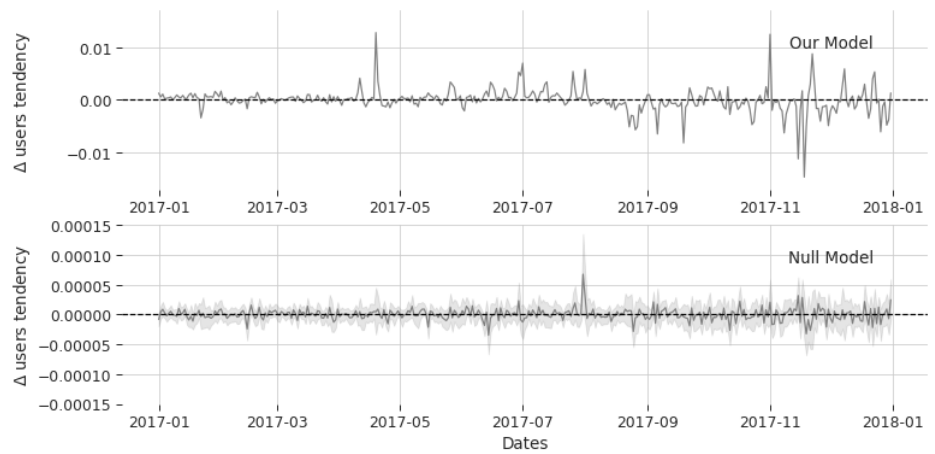
Figure 8. Daily difference in the number of users between empathy and threat groups. Top: our model, and bottom: the null